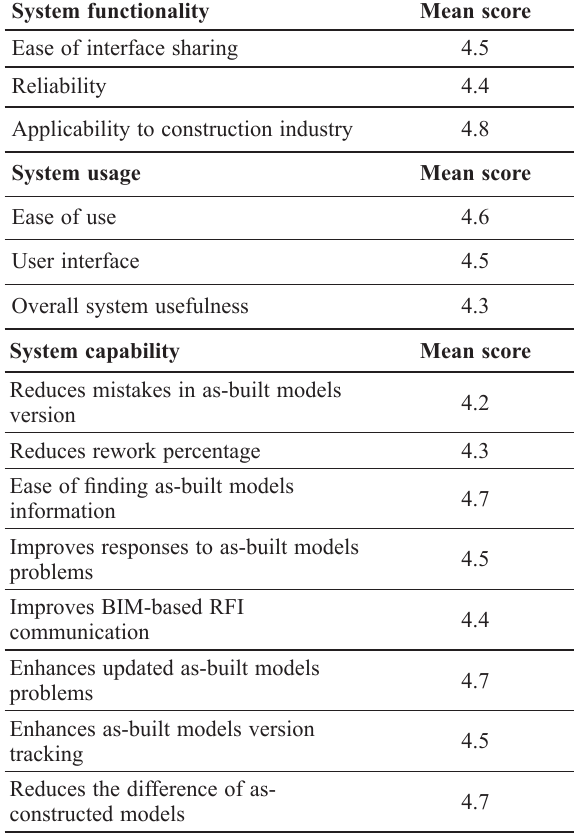
Table 3. System evaluation result System